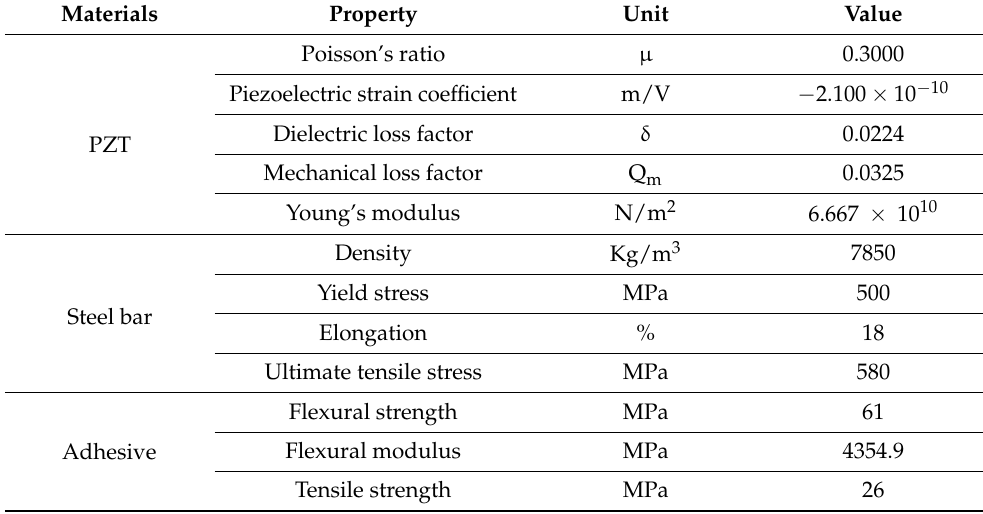
Table 2. Material Properties of PZT